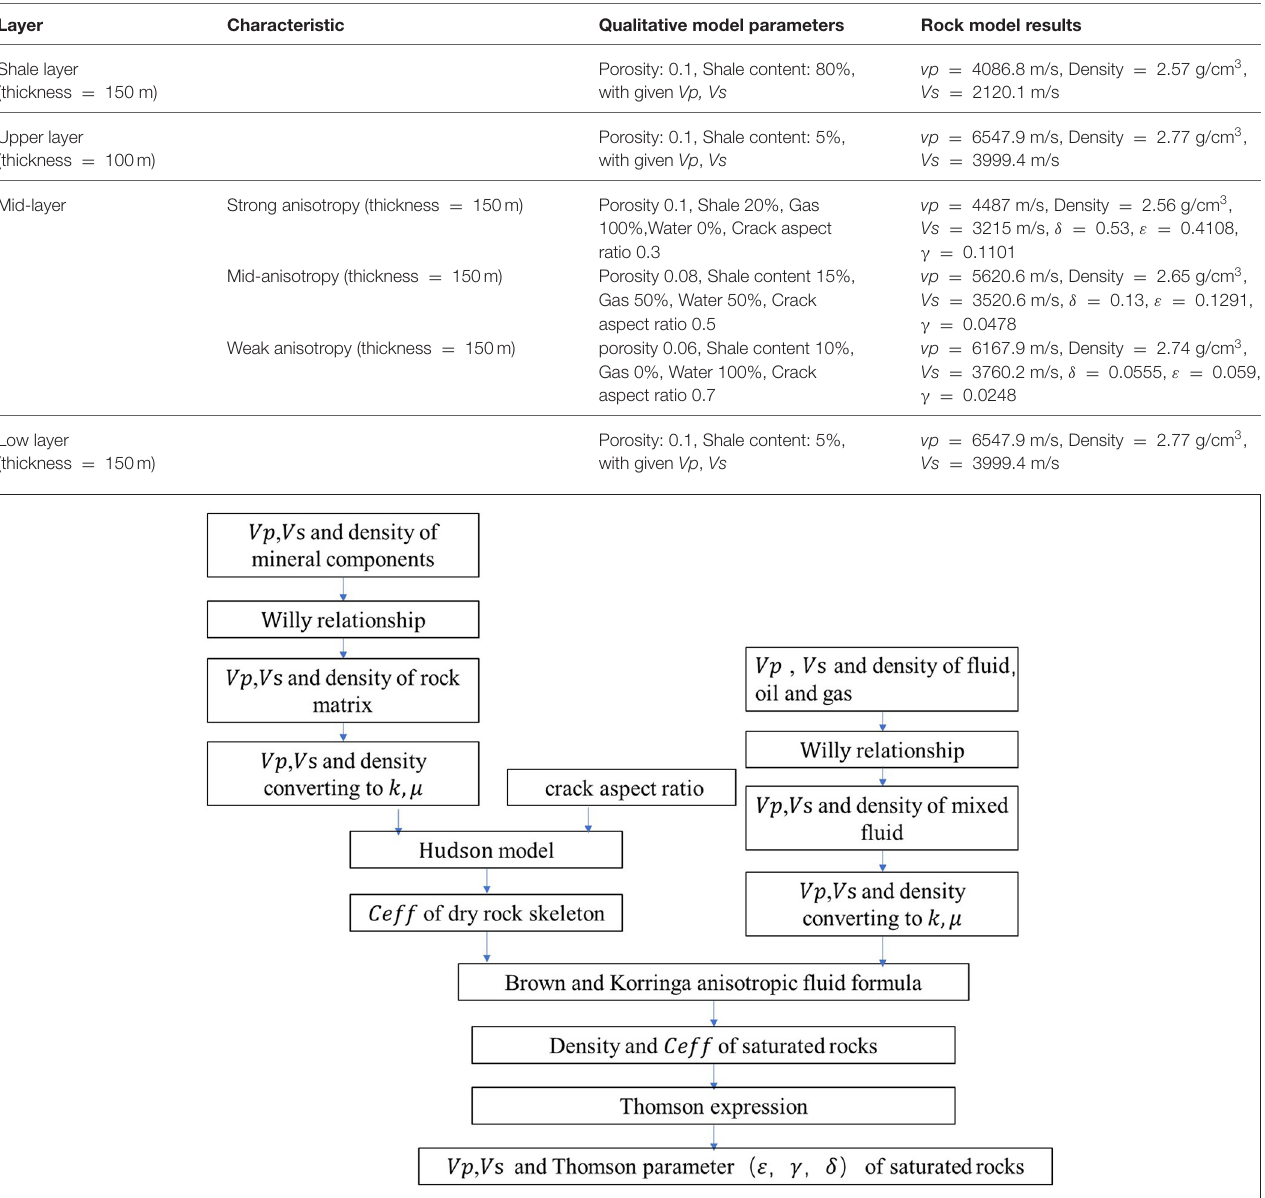
TABLE 1 | Qualitative model parameters.